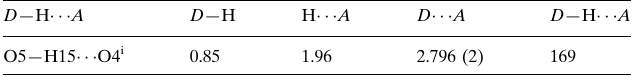
Hydrogen-bond geometry (A˚ , (cid:2)